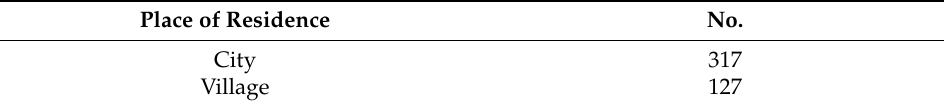
Table 1. Sample characteristics.